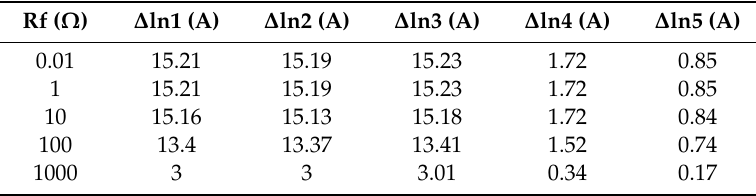
Table 4. Negative sequence currents in rural isolated